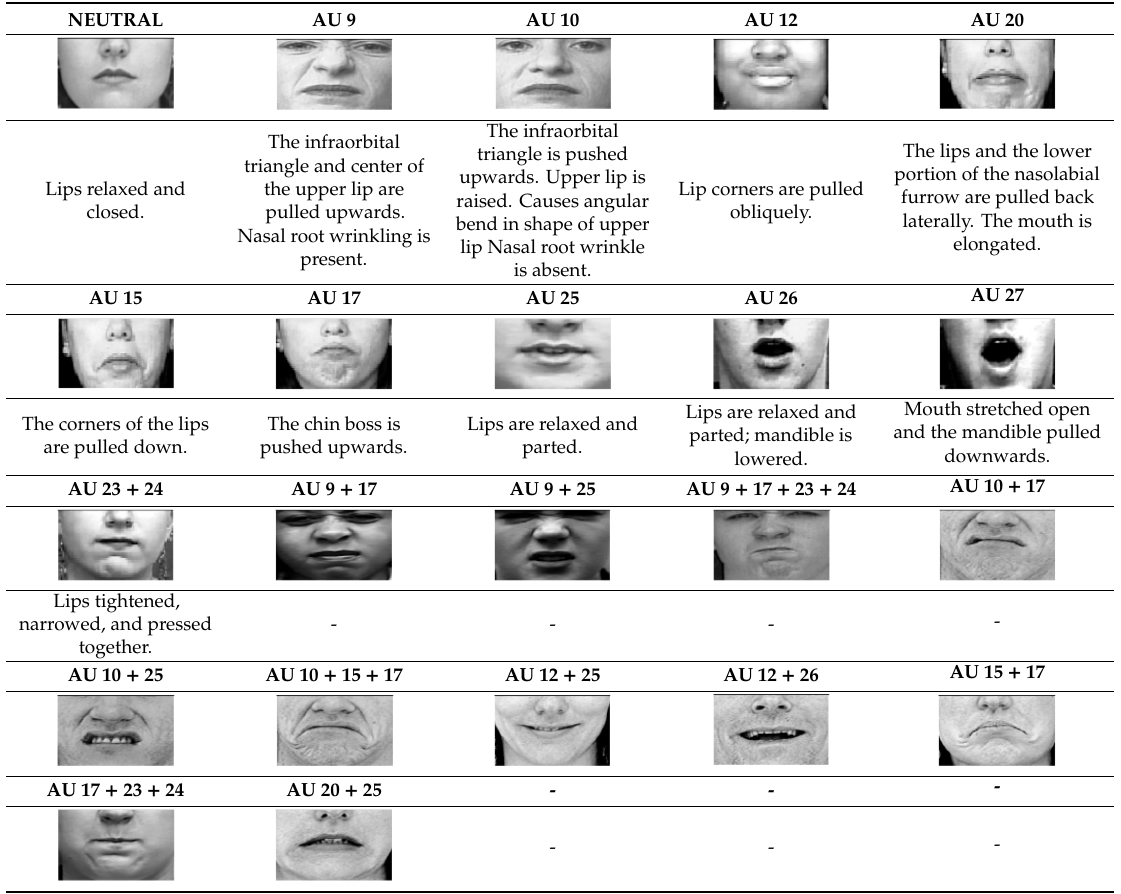
Figure 2. Feature point outline map formed by connecting facial feature points. According to the codes in Ekman and Friesen’s FACS, smiling can cause a lift in the cheeks (AU6) and in the corner of the mouth (AU12). A comparison of AU6 and AU12 with the feature points identified using Luxand FaceSDK helps trace the lines from point 23 to point 3 and from point 26 to point 4, which determine if a person in the image is smiling. However, in motion images, the distance from the camera or the position of one’s face (e.g., lowering of the head) can hinder the determination of whether a participant is happy. More specifically, these factors might shorten the length of the lines, and this could result in a misjudgment. Thus, this study uses two different lines, that is, from the two canthi to the philtrum (i.e., from point 23 to point 49 and from point 26 to point 49) as the standard length (Figure 3). Estimating the ratio of the two lines and the shortened standard line can help eliminate misjudgment and confirm a happy facial expression.